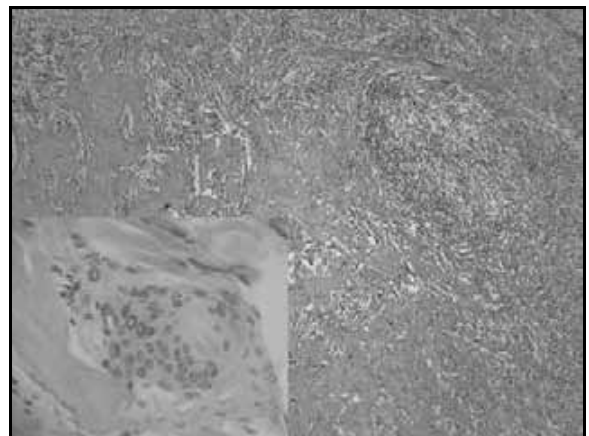
Figure 2 – A dense infiltrate of chronic inflammatory cells obscure the rare neoplastic meningothelial cells (HE 40×) HE: